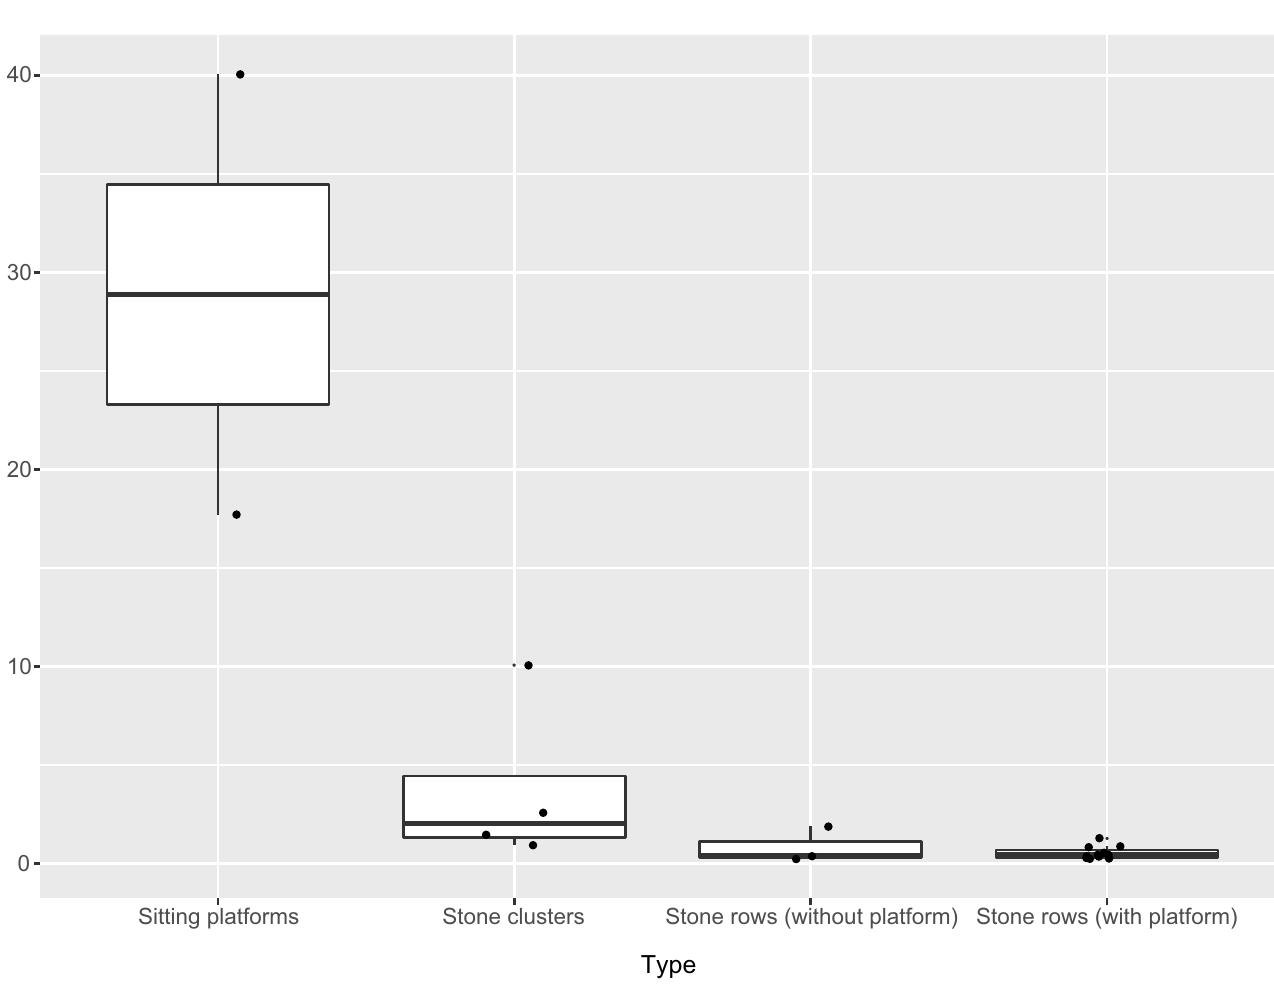
Fig 8. The four different types of megalithic monuments and their size distribution (m 3 ) in the Chakhesang Naga village of Ru¨nguzu (M. Wunderlich).